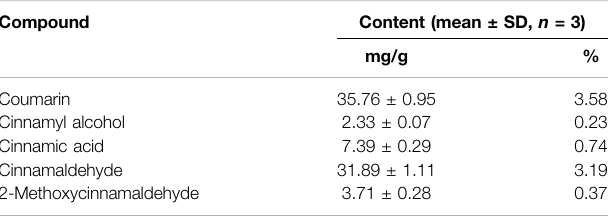
TABLE 2| Contentsof fi vecompoundsinthe70%ethanolextractof C.cassia (L.) J.Presl. Compound